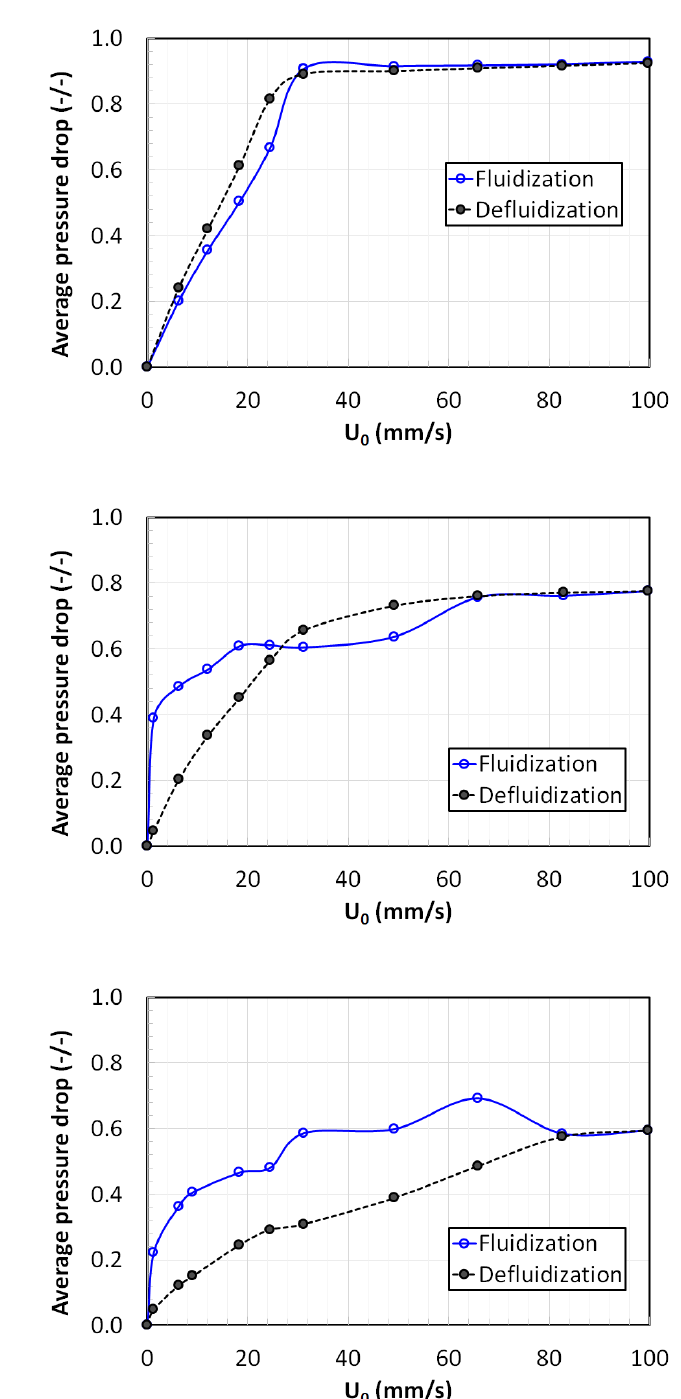
Figure 2. Hysteresis effect between fluidization and defluidization runs for conventional fluidized beds; ( a ) Glass beads; ( b ) Titania; ( c ) Nanosilica.